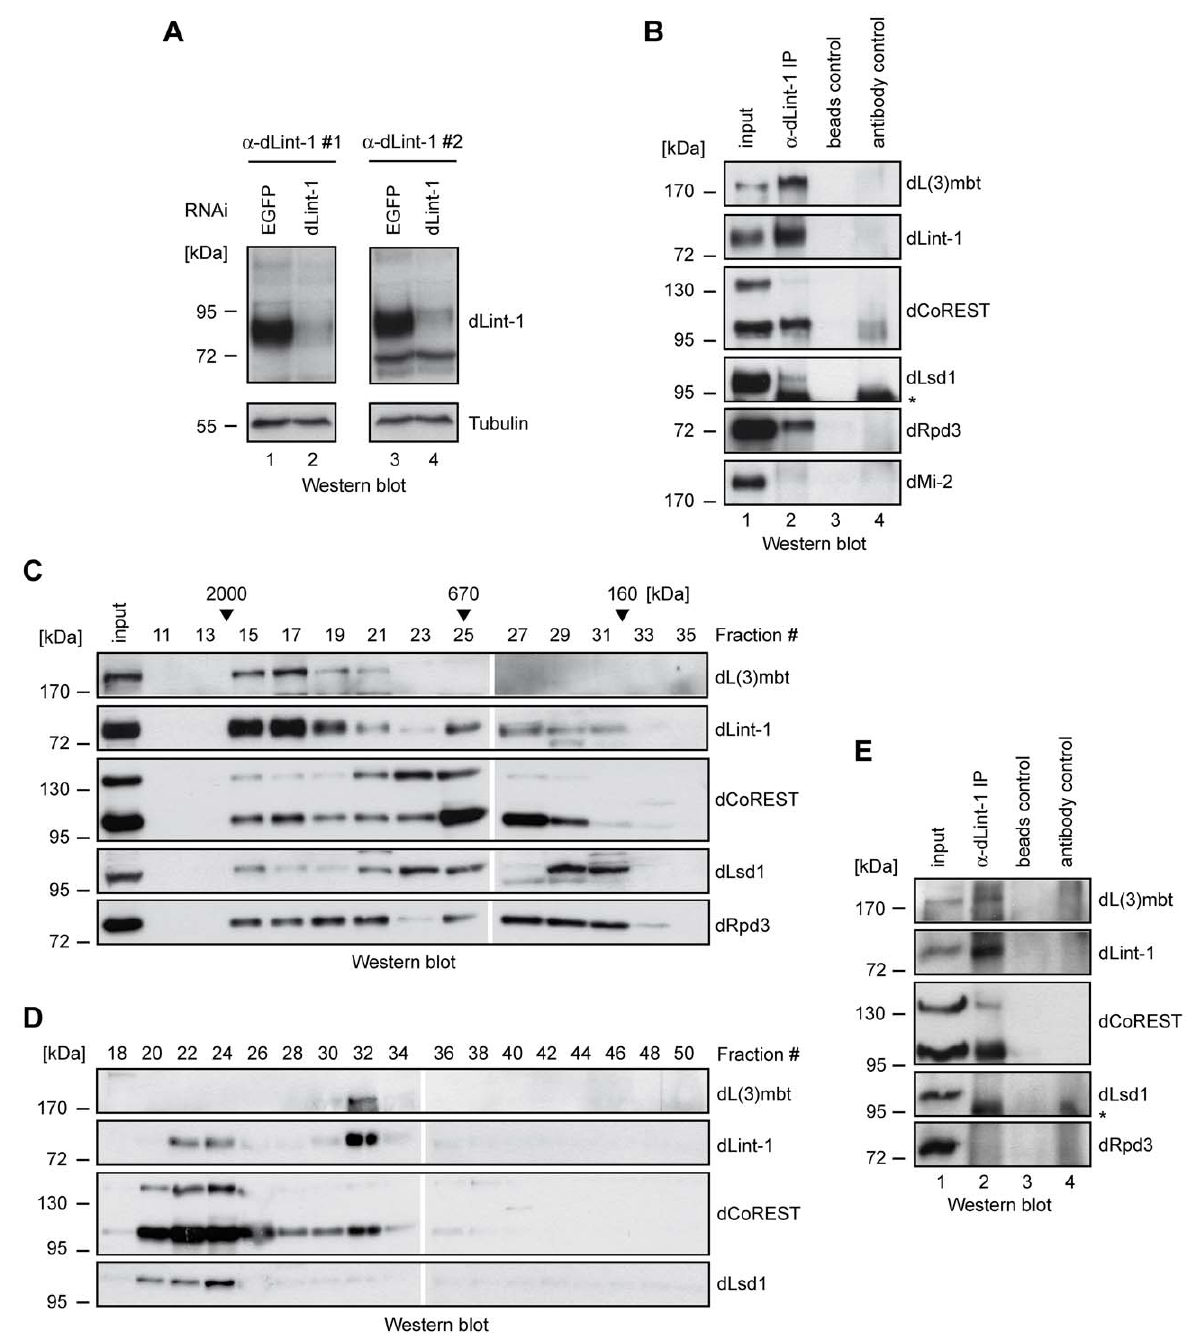
Figure 2. Purification of the LINT complex. (A) Nuclear extracts of Kc cells treated with dsRNA directed against EGFP (control, lanes 1 and 3) and dLint-1 (lanes 2 and 4) were subjected to Western blot using dLint-1 antibody # 1 (left upper panel), dLint-1 antibody # 2 (right upper panel) and tubulin antibody (lower panels). (B) Nuclear extracts from Kc cells were precipitated with protein G beads (beads control, lane 3) and beads loaded with dLint-1 # 1 antibody (lane 2) and analyzed by Western blot as indicated (lanes 2 and 3). dMi-2 served as a negative control. Lane 1: 5% input; lane 4 contains dLint-1 antibody (antibody control). * denotes a polypeptide that unspecifically crossreacts with the dLsd1 antibody (compare lanes 2 and 4). (C) Nuclear extract from Kc cells was fractionated over a Superose 6 column. Fractions were analyzed by Western blot. Fraction numbers and molecular mass standards are denoted on top. Input: 5% of extract loaded. (D) Kc nuclear extract was separated by sequential ion exchange chromatography over Q-Sepharose and MonoQ columns. MonoQ fractions were analyzed by Western blot as indicated. Fraction numbers are denoted on top. (E) Extract from third instar larval brains was precipitated with protein G beads (beads control, lane 3) and beads loaded with dLint-1 antibody (lane 2) and analyzed by Western blot as indicated (lanes 2 and 3). Lane 1: 5% input; lane 4 contains dLint-1 antibody (antibody control). * denotes a polypeptide that unspecifically crossreacts with the dLsd1 antibody (compare lanes 2 and 4).